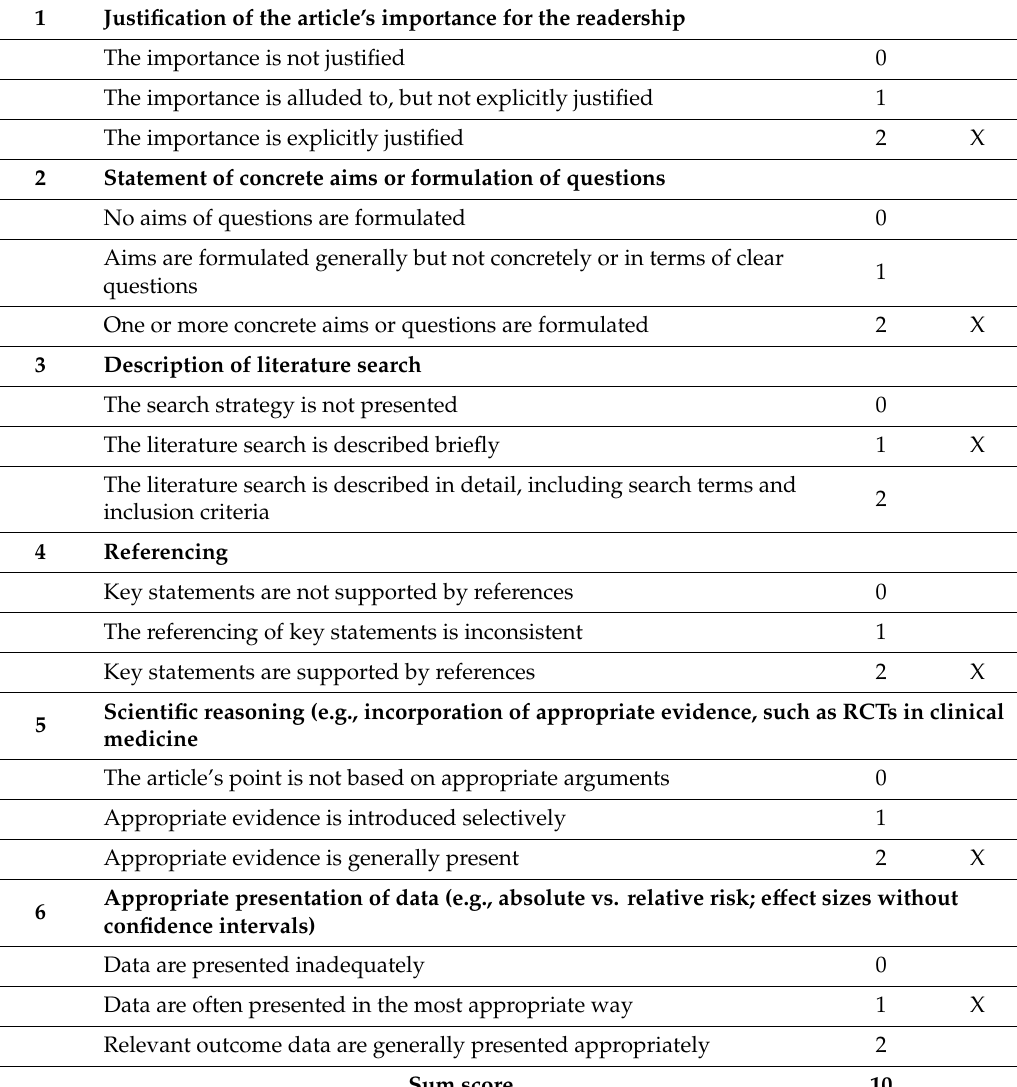
Table A1. Scale for the Assessment of Narrative Review Articles (SANRA). We rated the content of this manuscript according to the Scale for the Assessment of Narrative Review Articles (SANRA) [5]. The sum score was 10 out of a maximum of 12 points indicating a high-quality